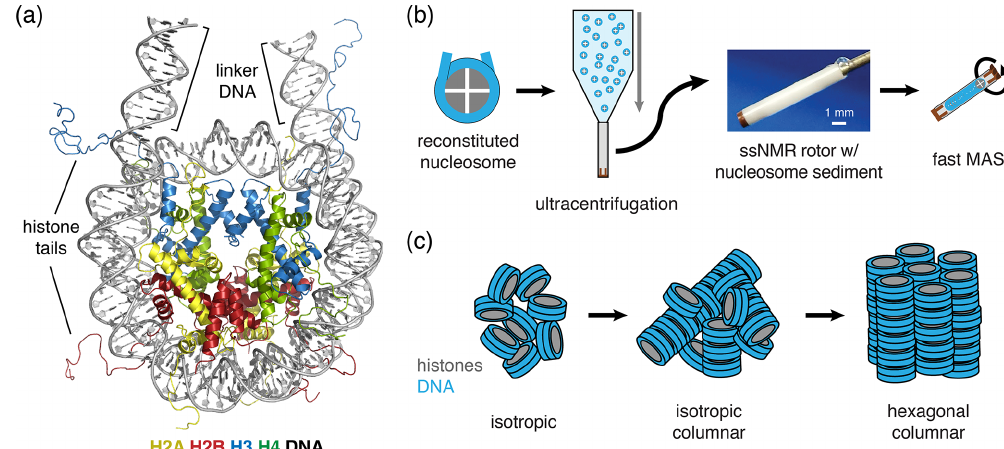
Figure 1. Schematic of nucleosome structure and sedimentation-based nucleosome NMR studies. (a) Structure of the nucleosome based on the crystal structure of the nucleosome core particle, extended with 10bp of linker DNA at each end. Linker DNA and two of the N-terminal histone tails (of one H3 and one H2B copy in the nucleosome) are indicated. Color coding indicated in the figure. (b) Overview of the sedimentation-based ssNMR study of nucleosomes. A dilute solution of nucleosomes is ultracentrifuged directly into the 1.3mm rotor to create a nucleosome sedimentation for 1 H detected ssNMR studies. A droplet of viscous liquid is visible at the top of rotor. (c) Schematic of nucleosome packing in dense phase as (from left to right) an unordered isotropic, isotropic columnar or highly ordered hexagonal columnar stacking of